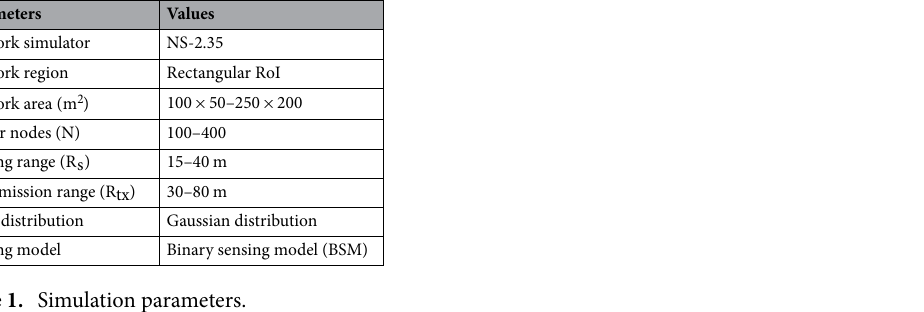
Table 1. Simulation